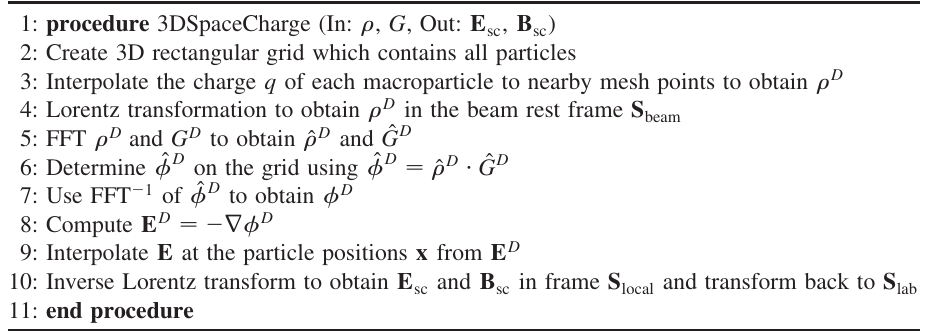
Algorithm 1. 3D space-charge